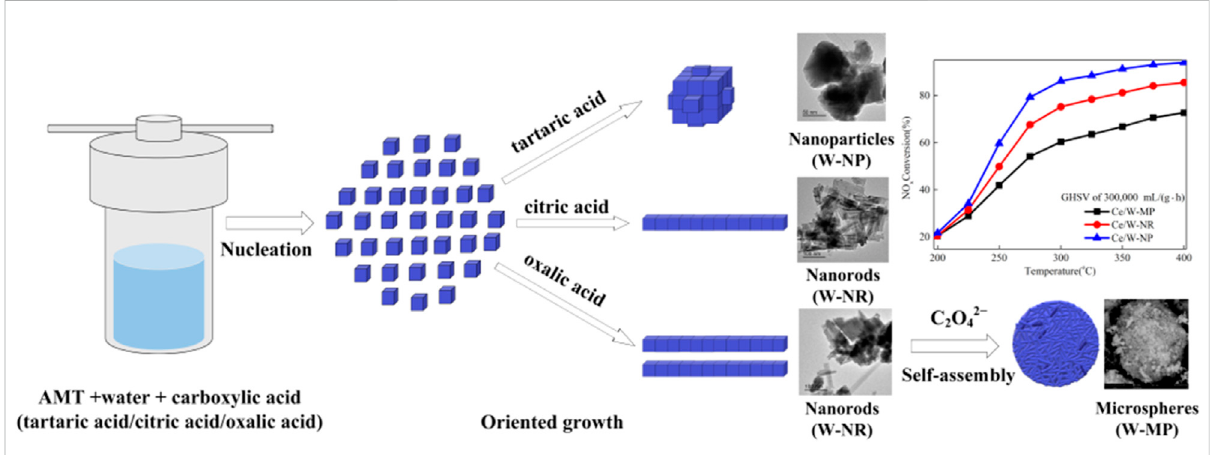
FIGURE 3 Preparation and performance of WO 3 supported CeO 2 SCR catalyst (He et al.,